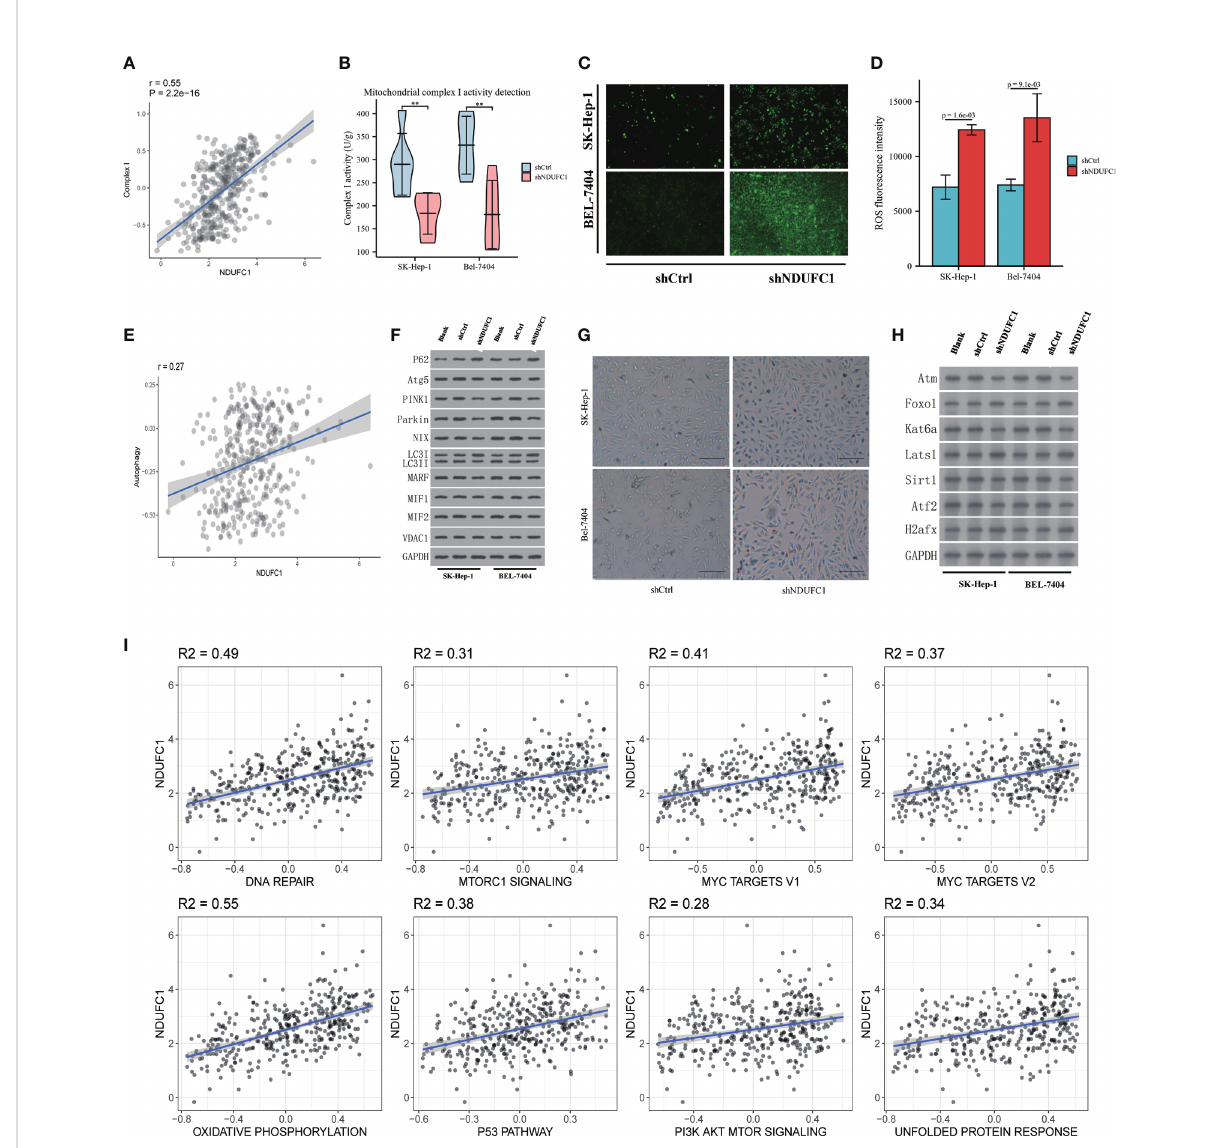
FIGURE 4 Tumor biological function of NDUFC1. (A) Bioinformatic analysis found positive correleation between Complex I and NDUFC1. (B) shNDUFC1 cell lines could inhibit the function of Complex I (C) ROS burden is up-regulated after NDUFC1 was knock down cell lines. (D) ROS fl ow cytometry assay showed that shNDUFC1 increased ROS burden. (E) Bioinformatic analysis found NDUFC1 is correlated with Autophagy. (F) shNDUFC1 could reduce autophagy in HCC cell lines. (G) SA- b -Gal analysis showed that shNDUFC1 induced senescence characteristics in SK-Hep-1 and Bel-7404. (bar = 100 m m). (H) Senescence related protein was correlated with NDUFC1 expression. (I) Cancer-associated cellular pathways analysis by NDUFC1 expression. MSigDB (http://www.gsea-msigdb.org/gsea/index.jsp) were used to analysis the cancer associated cellular pathways. The positive correlation analysis was found between NDUFC1 and multiple cancer-related pathways (R2 > 0.25 was considered as an interaction relationship). There was no negative correlation between NDUFC1 and multiple cancer-related pathways. **P <